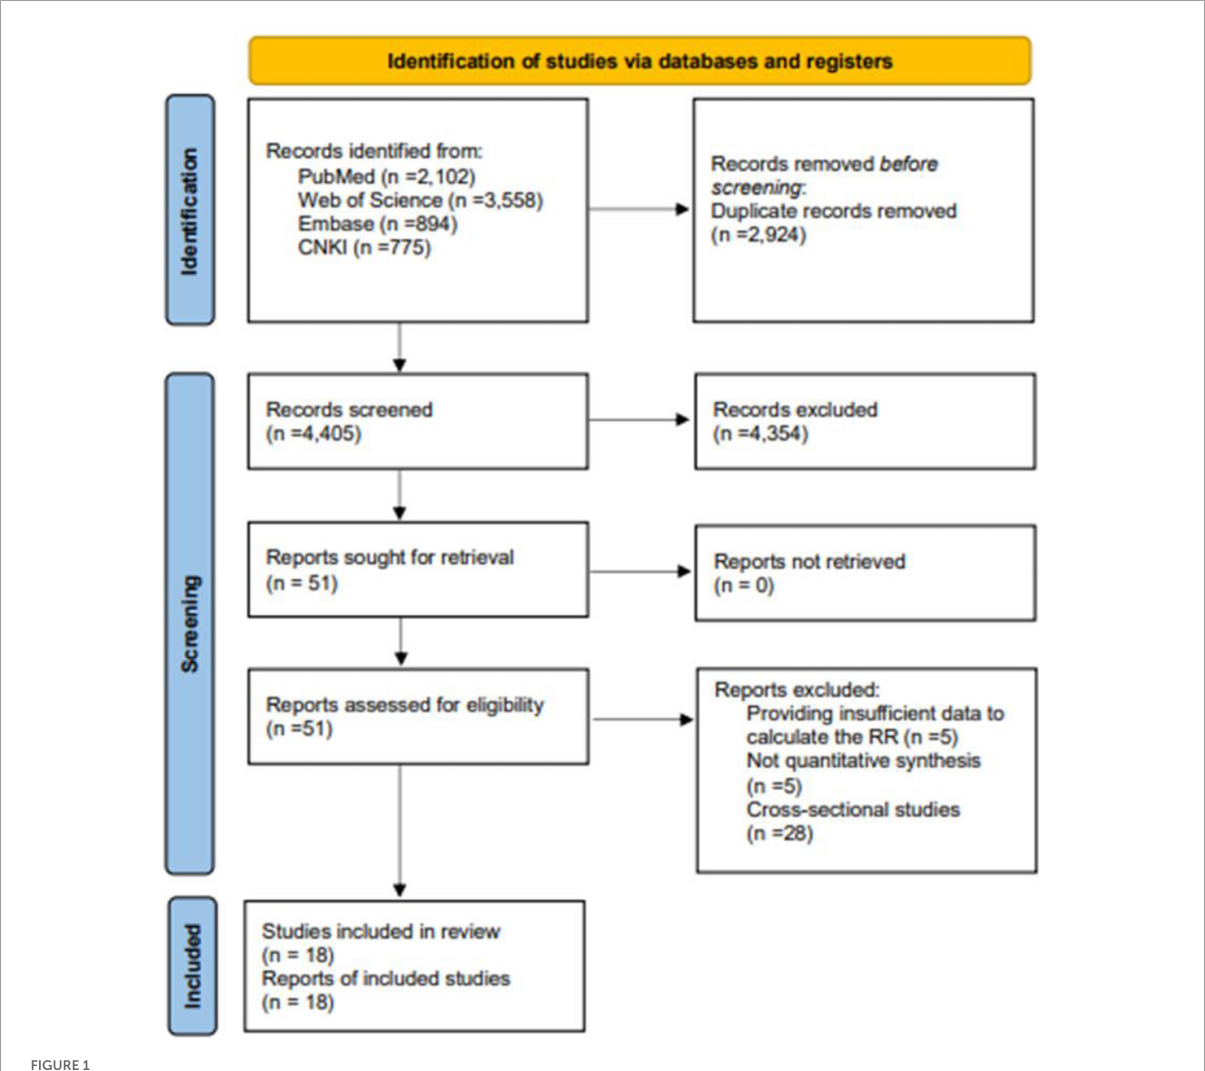
FIGURE1 Flow chart of study